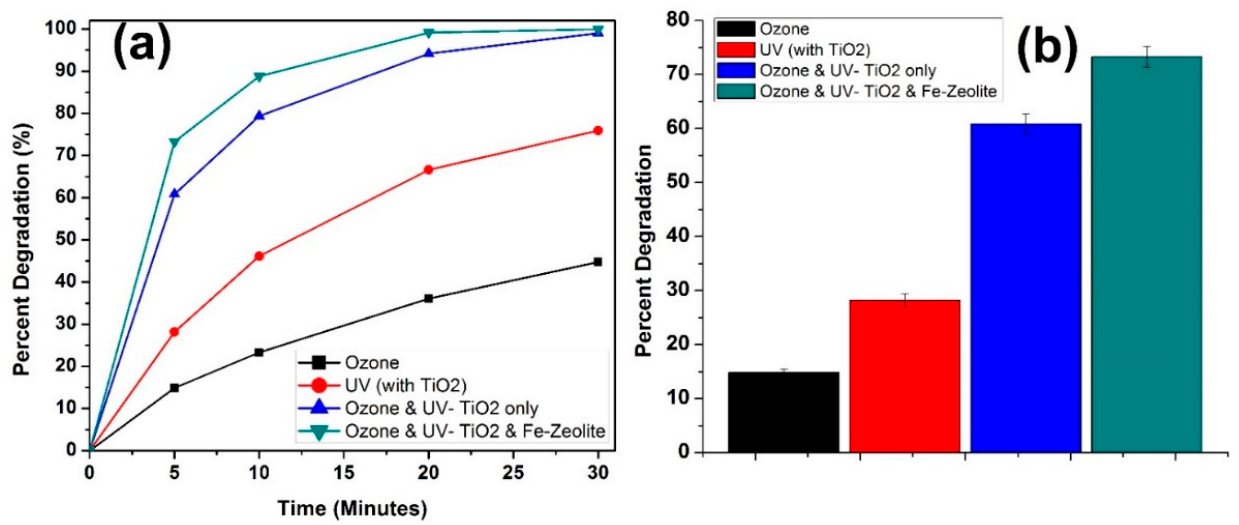
Figure 2. ( a ) Comparison of various AOPs for degradation of imidacloprid as a function of time, ( b ) percent degradation of Imidacloprid for different AOPs at a time interval of 5 min.